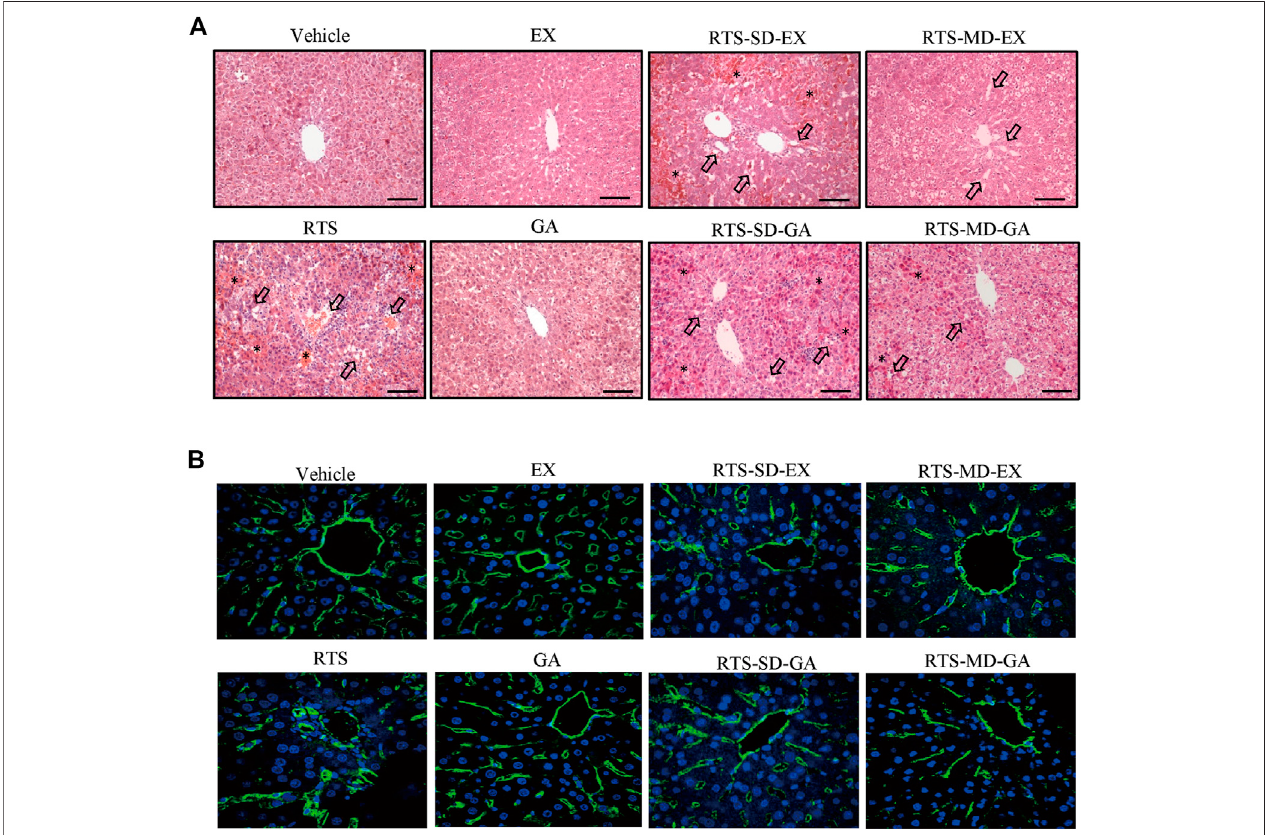
FIGURE 3 | Single-dose and multiple-dose of EX or GA protected against RTS-induced liver damage. (A) Hematoxylin and eosin staining of liver. Arrows indicate the necrosis of hepatocytes. *, hemorrhage; black scale bar, 100 µm. (B) Immunostaining of RECA-1 in liver sections. Sinusoidal endothelial cells (SECs) in central vein and pericentral area were immunostained with anti-endothelial cell antibody (green), nucleus stained with DAPI (blue).RECA-1, rat endothelial cell antigen-1.